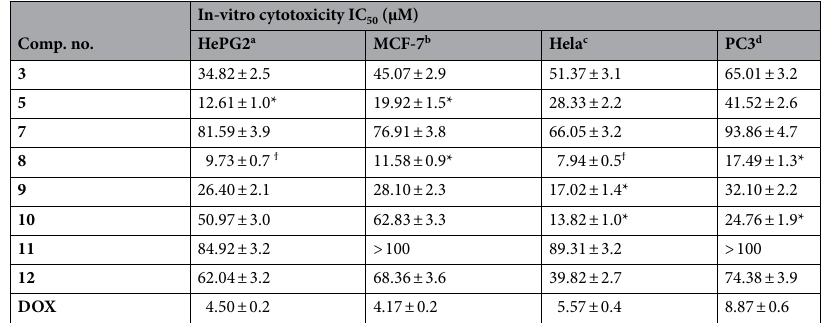
Table 1. In vitro antitumor activity (IC 50 , µM) of the tested hybrids 3 , 5 , 7 – 12 and DOX. a Hepatocellular carcinoma (HePG2). b Mammary gland breast cancer (MCF-7). c Epithelioid carcinoma cervix cancer (Hela). d Human prostate cancer (PC3). IC 50 : compound concentration required to inhibit tumor cell proliferation by 50% (mean ± SD, n = 3). IC 50 (µM). ϯ 1–10 (very strong), *11–25 (strong), 26–50 (moderate), 51–100 (weak), > 100 (non-toxic). DOX doxorubicin as a reference